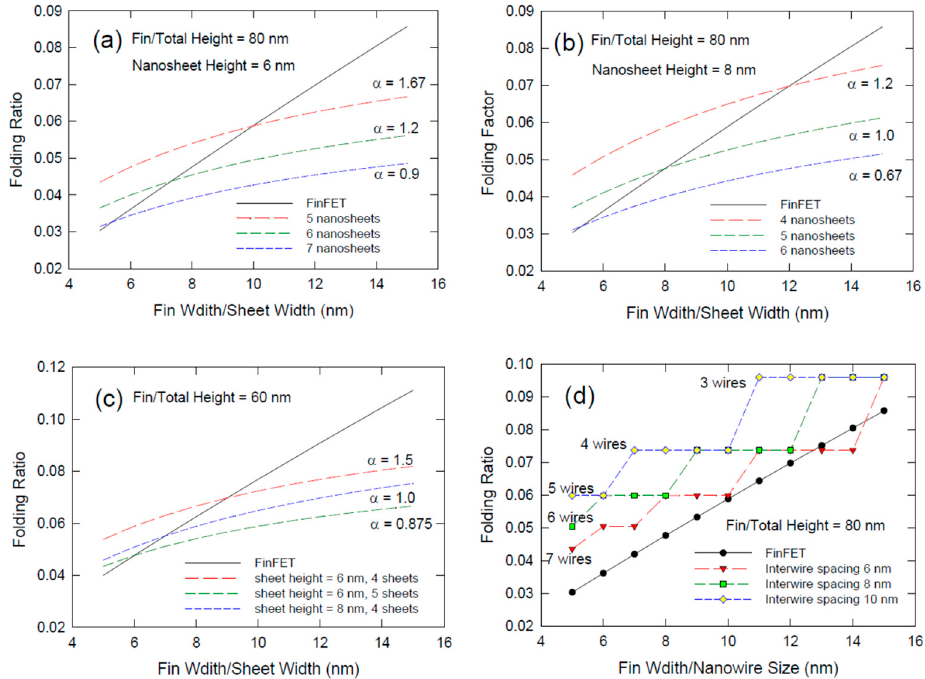
Figure 3. Comparison of the folding ratios as a function of fin width for different fin heigh, and different numbers of nanosheets/nanowires: ( a ) fin height = 80 nm, sheet height = 6 nm, different numbers of sheets are achieved by using different intersheet spacings; ( b ) fin heigh = 80 nm, sheet heigh = 8 nm; ( c ) fin height = 60 nm; and ( d ) different numbers of nanowires for VNWFET.